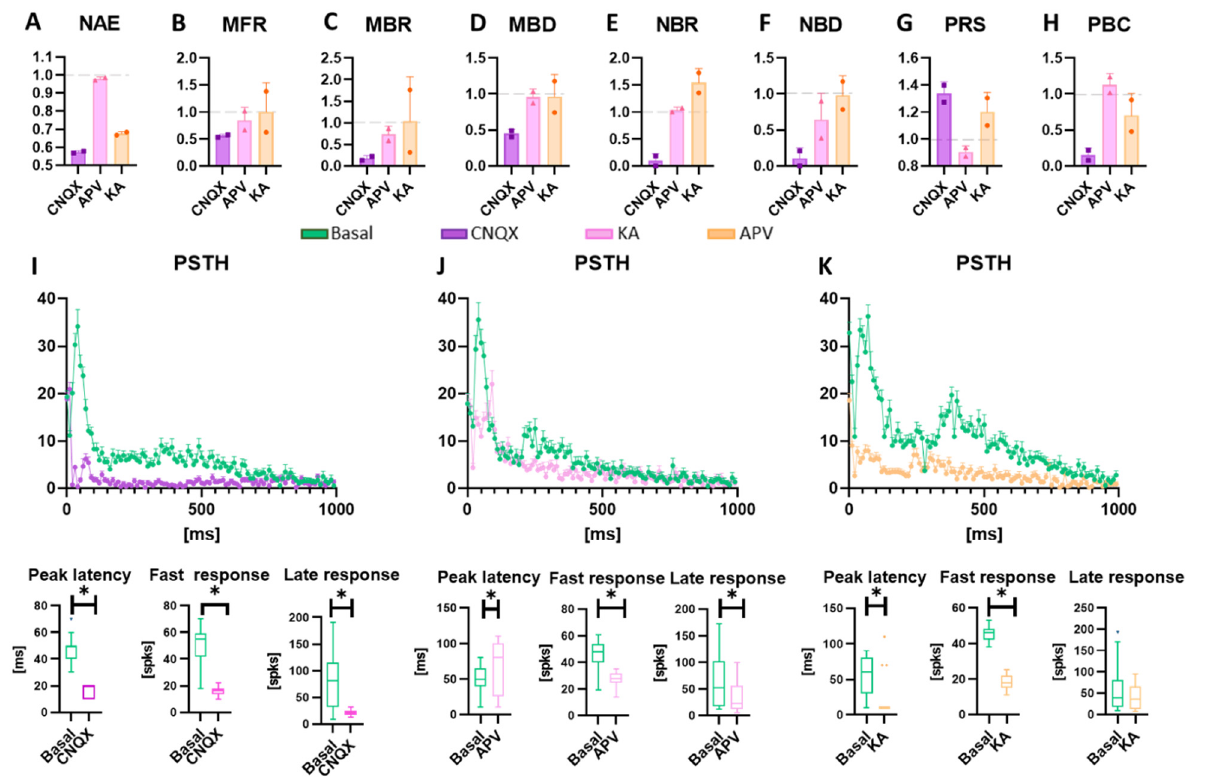
Figure 5. Evaluation of the electrical and chemical modulation of the activity. Data are obtained from experiments on HD-MEAs (n = 2) and are normalized to the value detected in spontaneous conditions in the absence of drugs. Data obtained with the MEA60 are reported in Supplementary Figure S1. ( A – H ) Graphs showing the ( A ) number of active electrodes (NAE), ( B ) mean fi ring rate